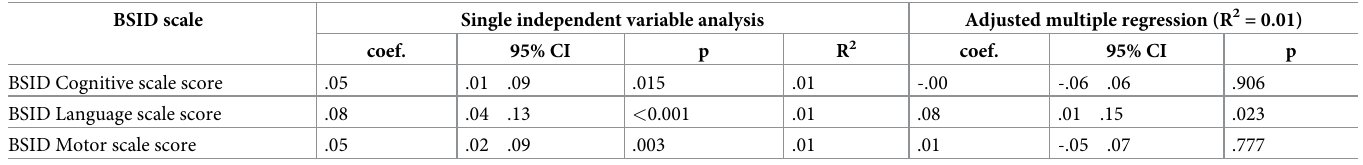
Table 5. Associations between BSID III composite and the WISC V FRI scores at 8 years in the cohort (N = 1141). BSID